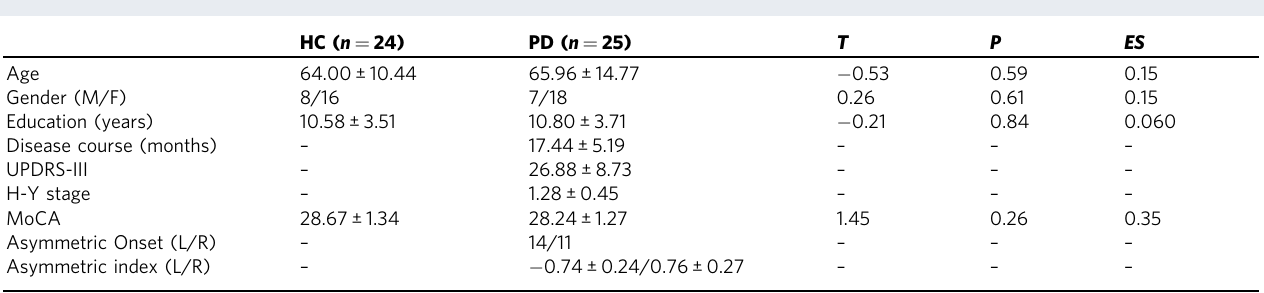
Table 1 Demographic and clinical characteristics of the participants included in the